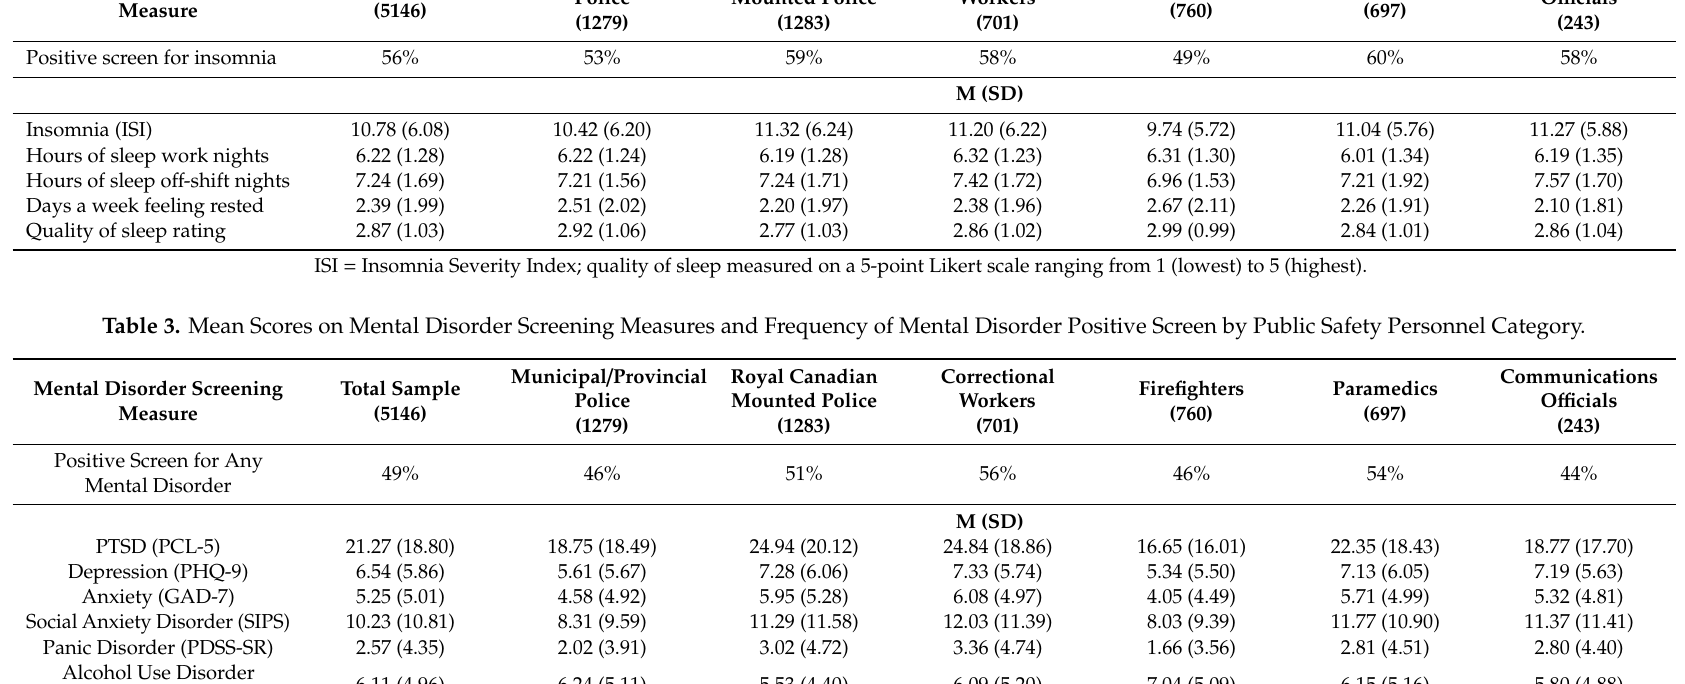
Table 2. Mean Scores on Sleep Quality Screening Measures and Frequency of Insomnia Positive Screen by Public Safety Personnel Category. Sleep Quality Screening Measure